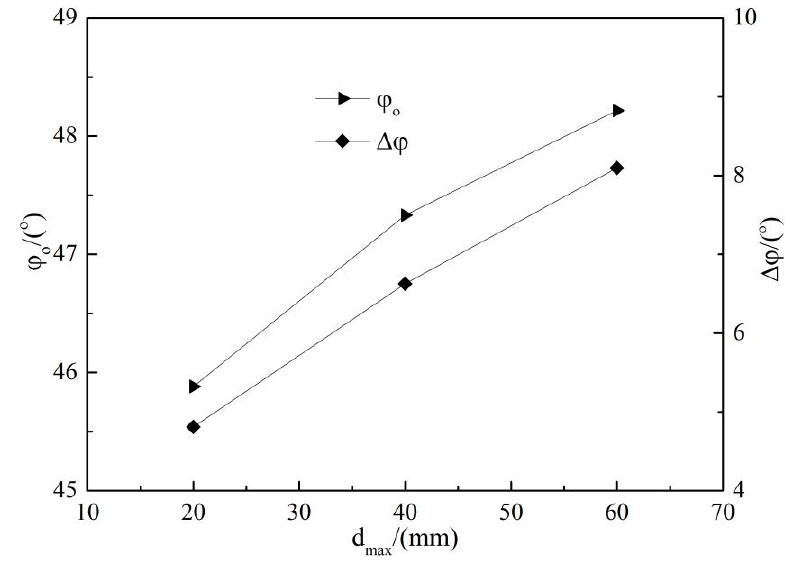
Figure 7. Relationship between ϕ 0 , ∆ ϕ and d max